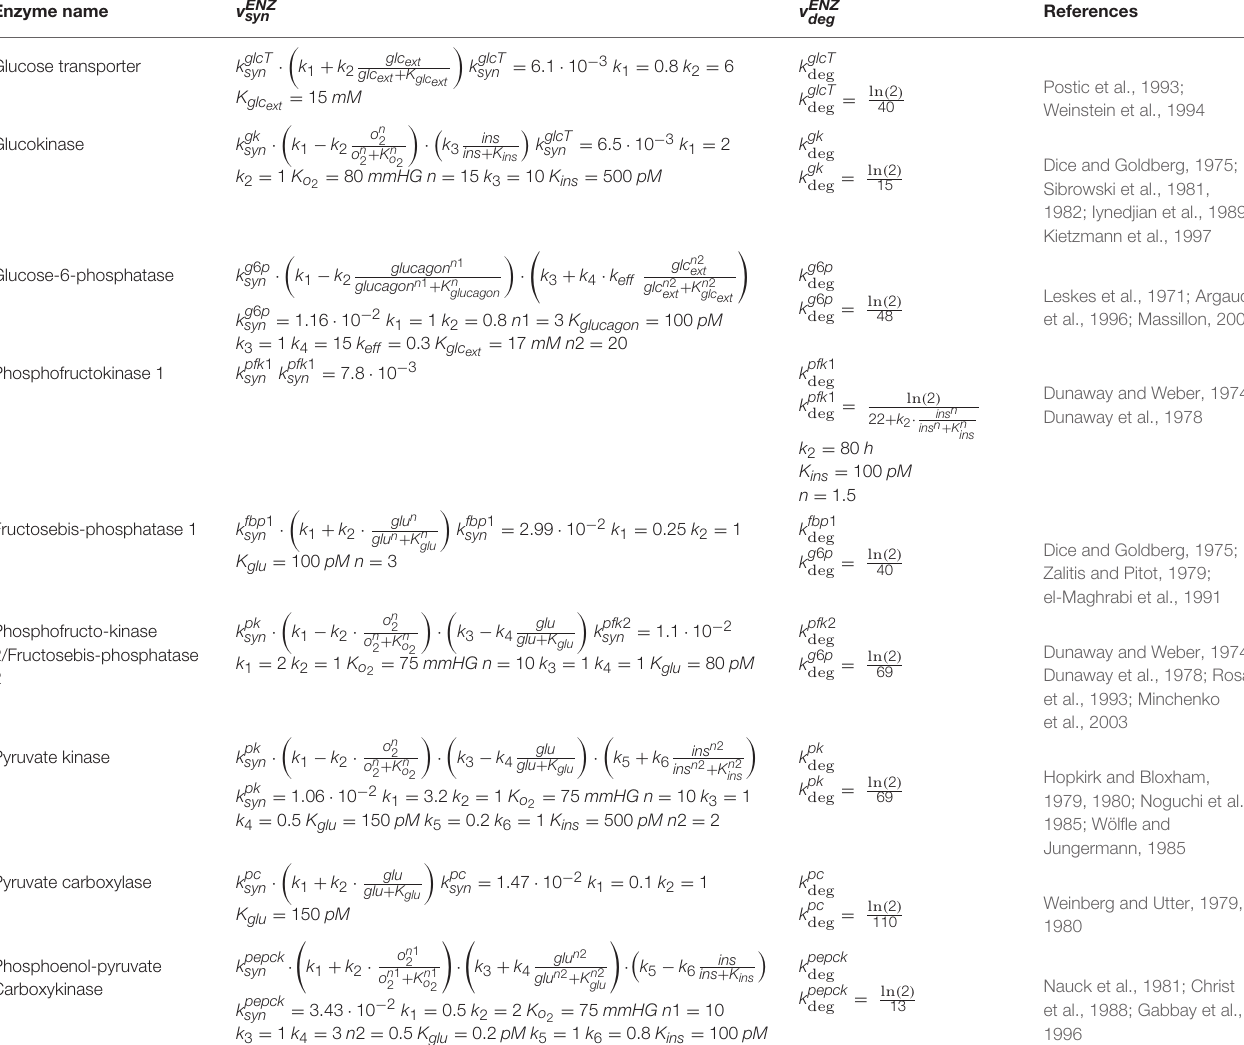
TABLE 1 | Synthesis and degradation rates of the regulatory enzymes of hepatic carbohydrate. Enzyme